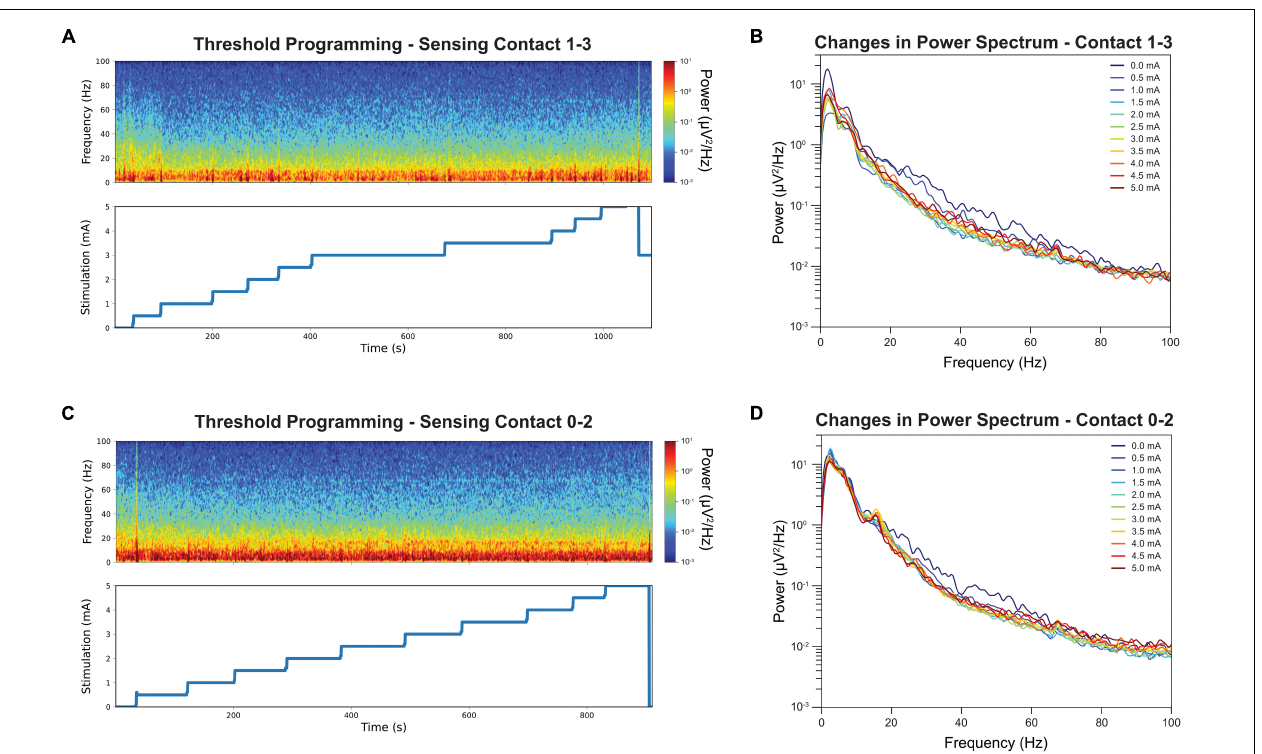
Eisinger et al., 2020) and externalized lead studies (Burgess et al., 2010). However, rigidity score was not changed by the stimulation in either therapy contact pairs. Our results